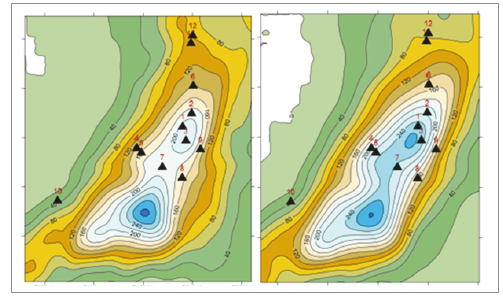
Figure 2: Precipitation casts from November 18, 2016 at 4:00 am GMT to 19 November 2016 at 6:00 am GMT, estimated from the Panthere radar product (left) and OHM-CV reanalysis